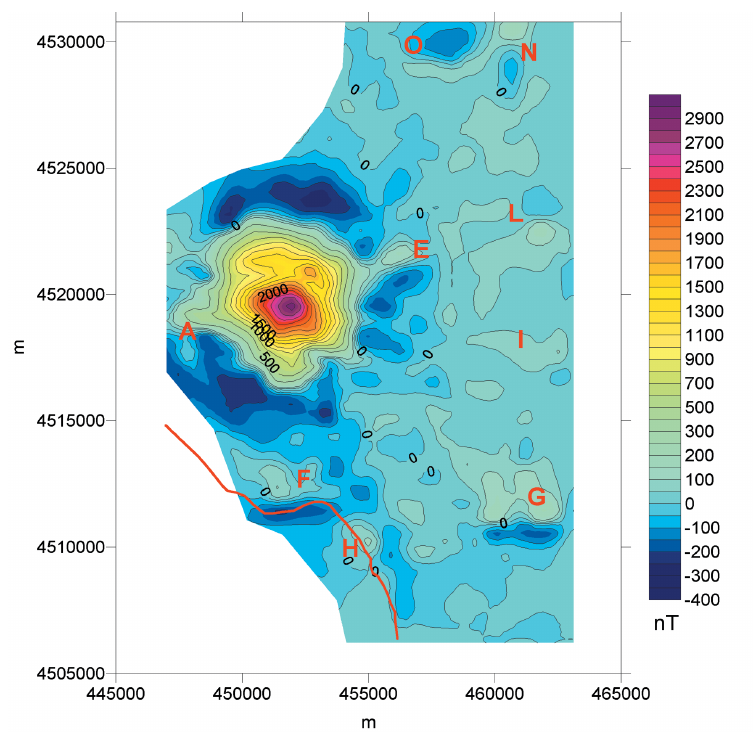
Fig. 6. Pole reduced map of the new magnetic data set of the Vesuvian area. Coastline in